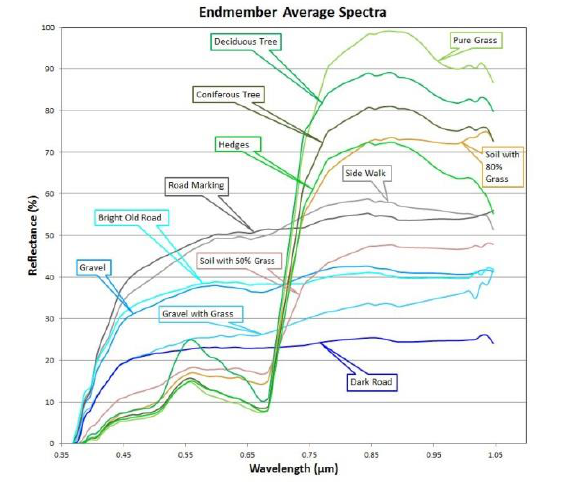
Figure 2.The endmember